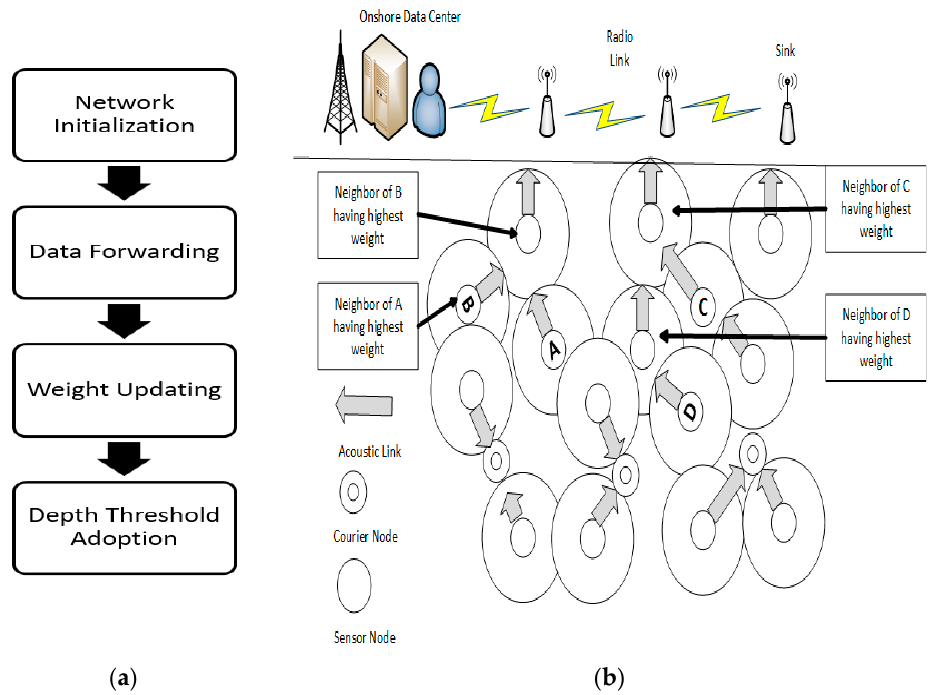
Figure 2. ( a ) Block diagram of AMCTD. ( b ) Data Transmission in AMCTD Protocol.